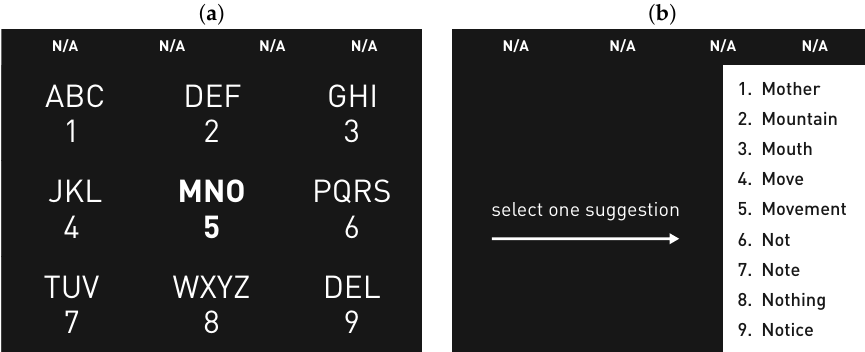
Figure 5. The GUI discussed in [75]. ( a ) The first stage where a target letter was selected; ( b ) Suggested words were displayed with the corresponding number. Figures modified from